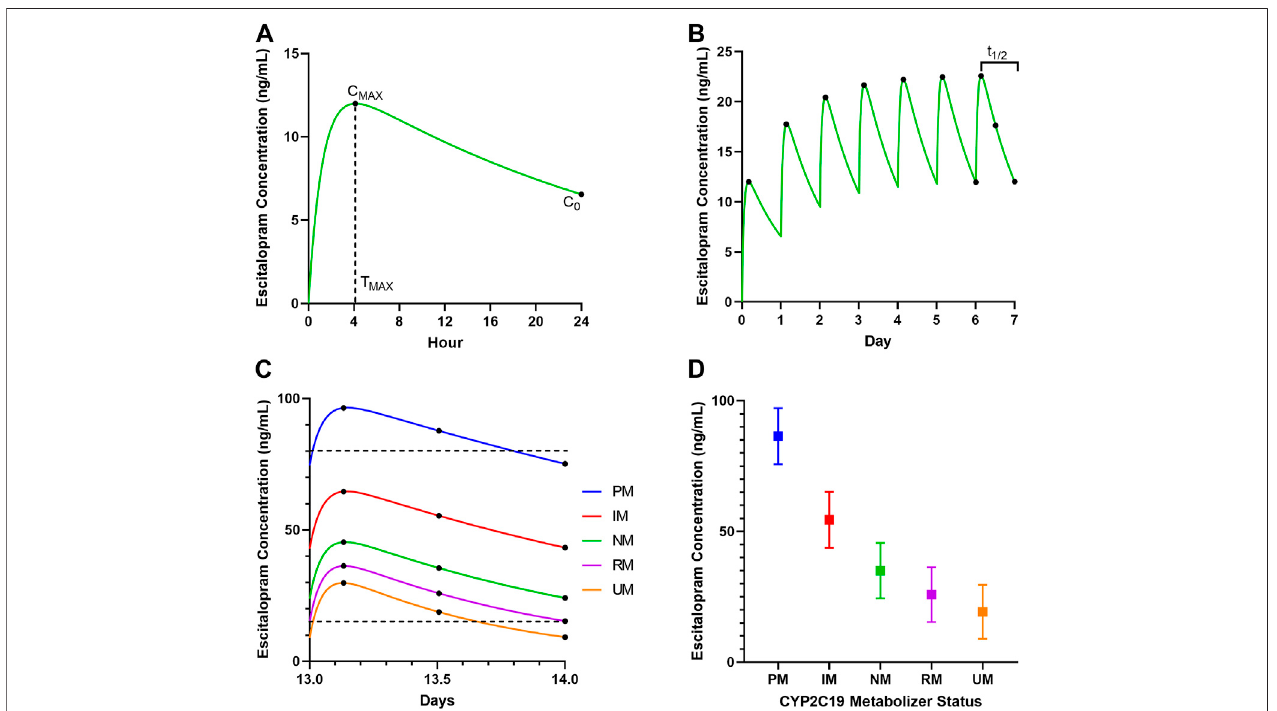
FIGURE 1 | The pharmacokinetics of escitalopram in a 14-year-old adolescent female. (A) Predicted concentration-time curve after a single 10 mg dose in a CYP2C19 normal metabolizer. The maximum concentration ( C MAX ), trough concentration ( C 0 ), and time to maximum concentration ( T MAX ) are shown. (B) Concentration-time curve showing seven doses of 10 mg every 24 h in a CYP2C19 normal metabolizer. Dots indicate the C MAX after each dose, the C 0 prior to the seventh dose and the concentrations at 12 and 24 h after the seventh dose. The half-life (t 1/2 ) is shown by the bracket above the curve for the seventh dose. (C) Escitalopram concentrations after the 14th dose of 20 mg/day are shown for a CYP2C19 poor metabolizer (blue, [PM]), intermediate metabolizer (red, [IM]), normal metabolizer (green, [NM]), rapid metabolizer (purple, [RM]) and ultrarapid metabolizer (orange, [UM]). Dots indicate the maximum concentration after the dose and the concentrations at 12 and 24 h after the 14th dose. Dotted lines indicate therapeutic window (Hiemke et al., 2018). (D) For each metabolizer phenotype, the squares indicate the concentration at 12 h after the 14th dose of 20 mg/day, with the whiskers indicating the maximum concentration ( C MAX ) and the trough concentration ( C 0 ).